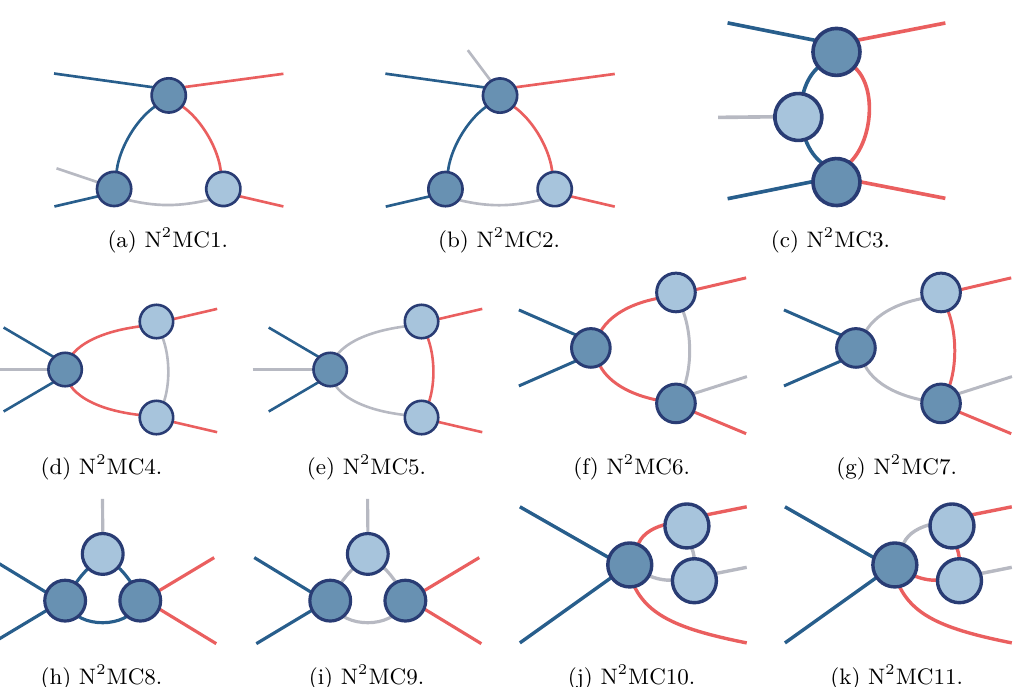
Figure 9 . N 2 -maximal triangle cuts of the one-loop five-point amplitude. Light blue blobs represent three-point amplitudes, darker blobs represent four and five-point amplitudes, and exposed legs represent on-shell propagators.